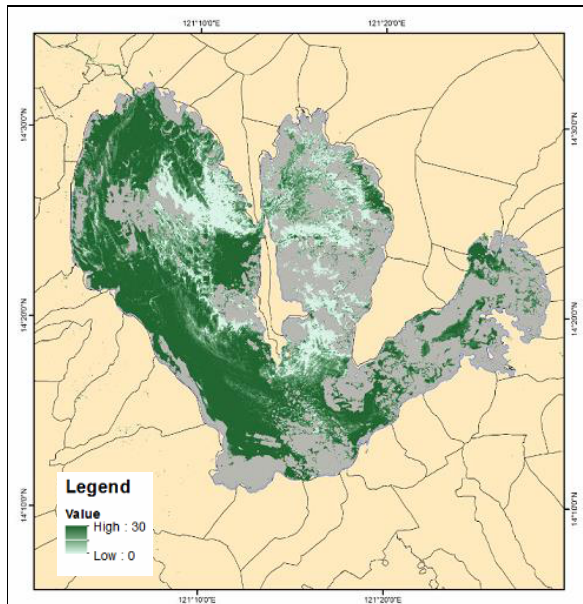
Figure 8. BOMBER tool derived CHL-A Map of Oct 16, 2018